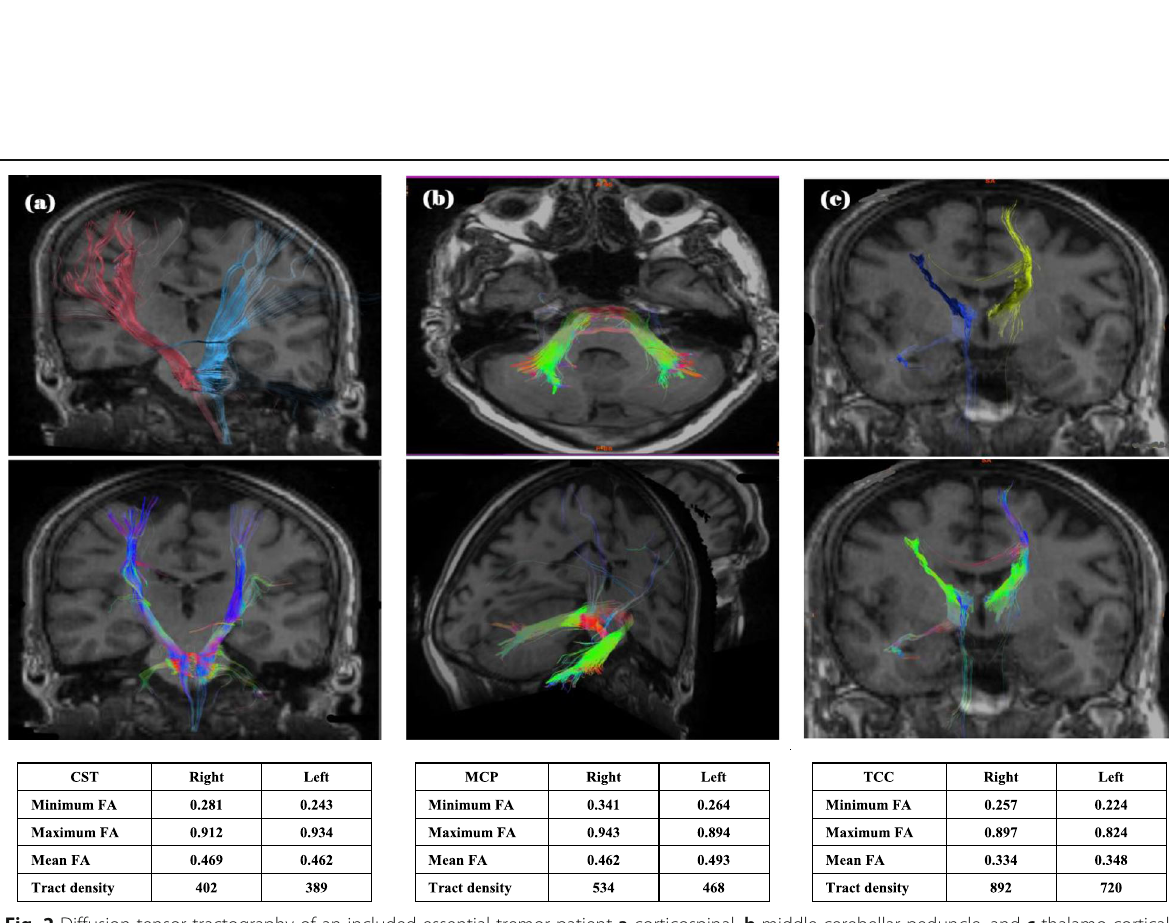
Fig. 1 Computerized dynamic posturography sensory analysis ratios of an essential tremor patient showing impaired visual and vestibular inputs with normal somatosensory balance systems